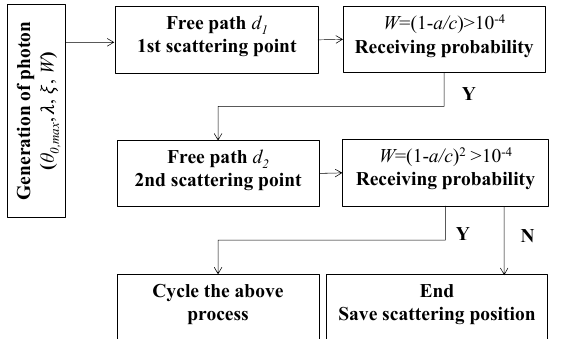
Figure 3. Flow chart of Monte Carlo model for photocounting receiver.